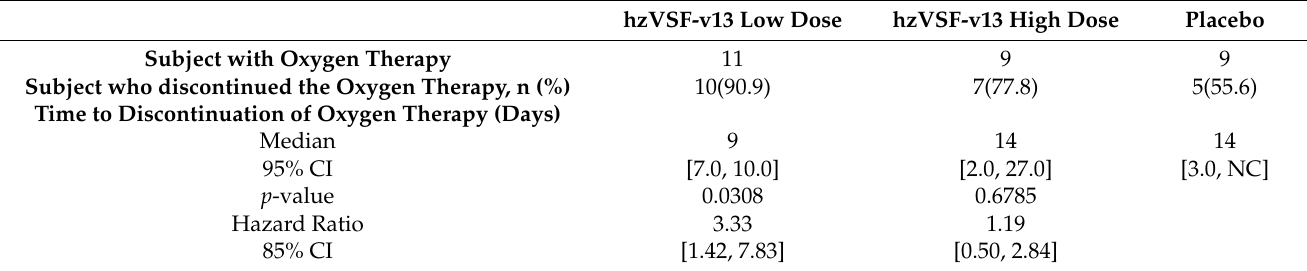
Figure 3. Change from baseline in the ordinal scale for clinical improvement score (OSCI, WHO 2020). Table 5. Time to discontinuation of oxygen therapy in the severe stratum (NC = not